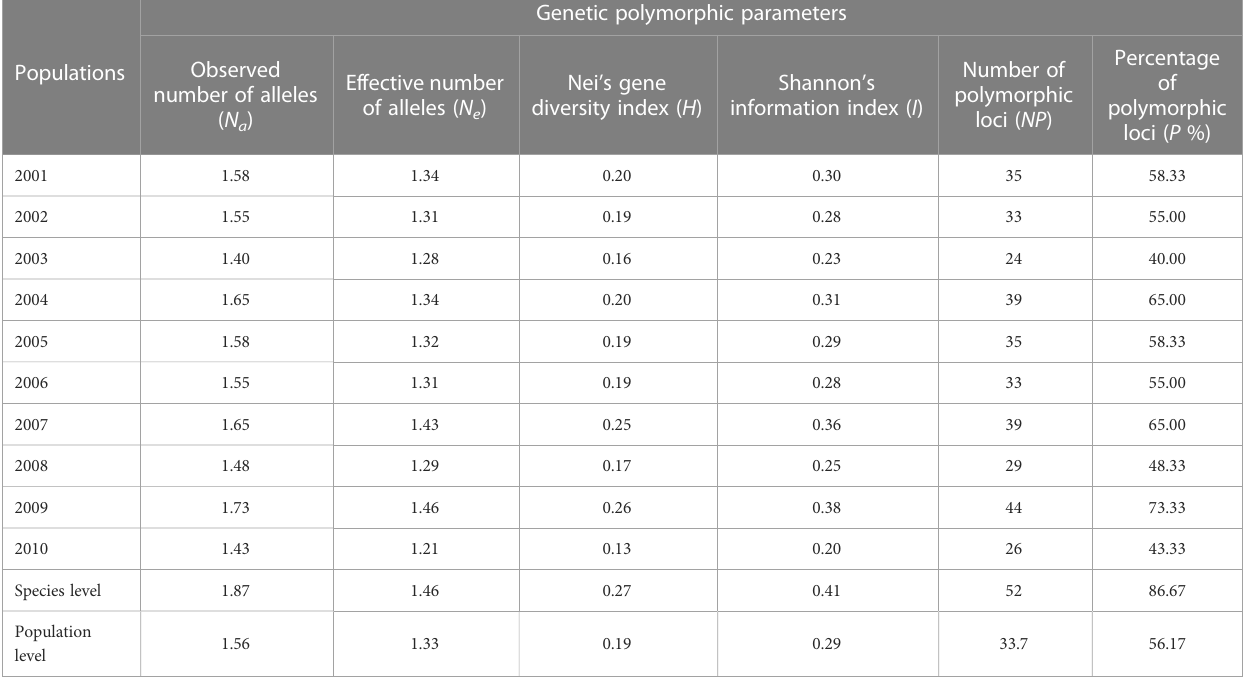
TABLE 4 Genetic diversity parameters of 10 Puccinia triticina populations based on EST-SSR.